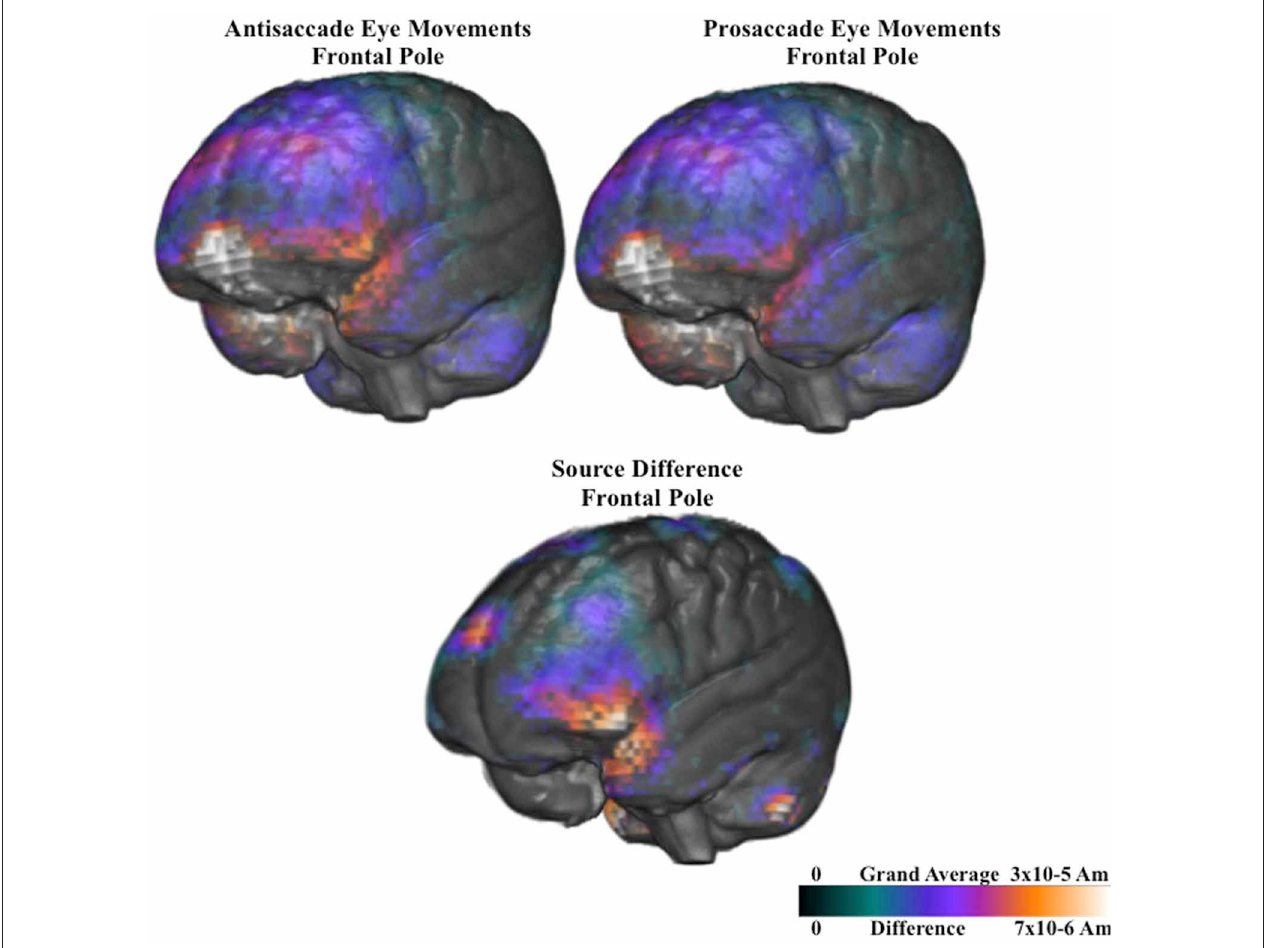
FIGURE 10 | Current density reconstruction of the pretarget ERP for the frontal pole activity for prosaccade and antisaccade eye movements. The difference construction is for the difference between the prosaccade and antisaccade source models.